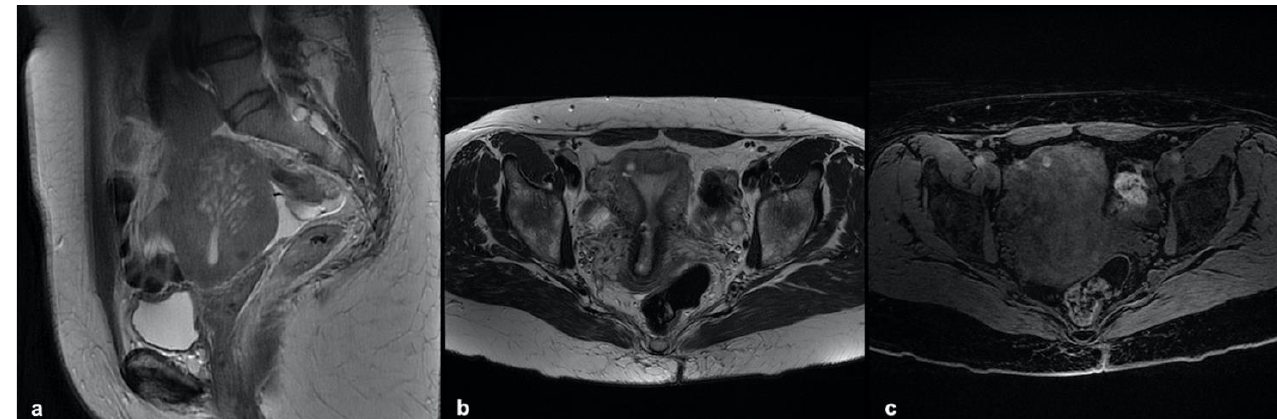
Figure 1. Focal internal adenomyosis. ( a ) Sagittal T2-weighted image showing a sub-endometrial tiny cyst with high-signal-intensity areas and JZ hypertrophy in both anterior and posterior uterine fundus. ( b ) Axial T2-weighted image showing an isolated sub-endometrial cyst characterized by both high signal intensity on T2- and high signal intensity on T1-weighted image ( c ) due to the hemorrhagic content.